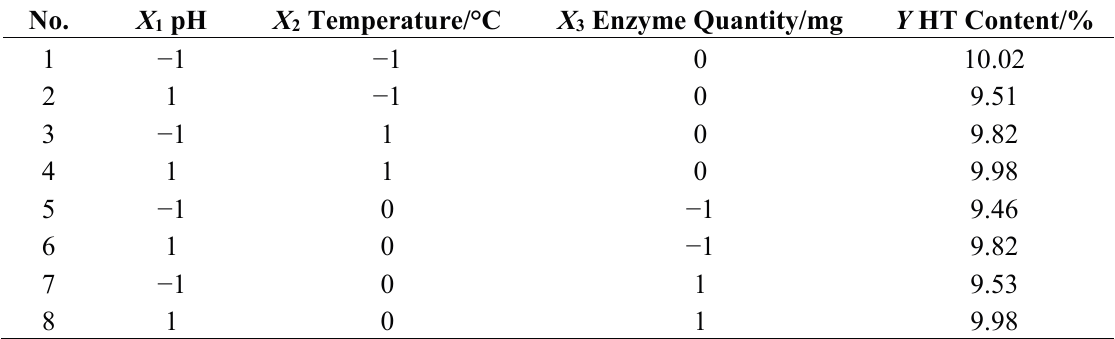
Table 1. Box-Behnken experimental design and corresponding HT